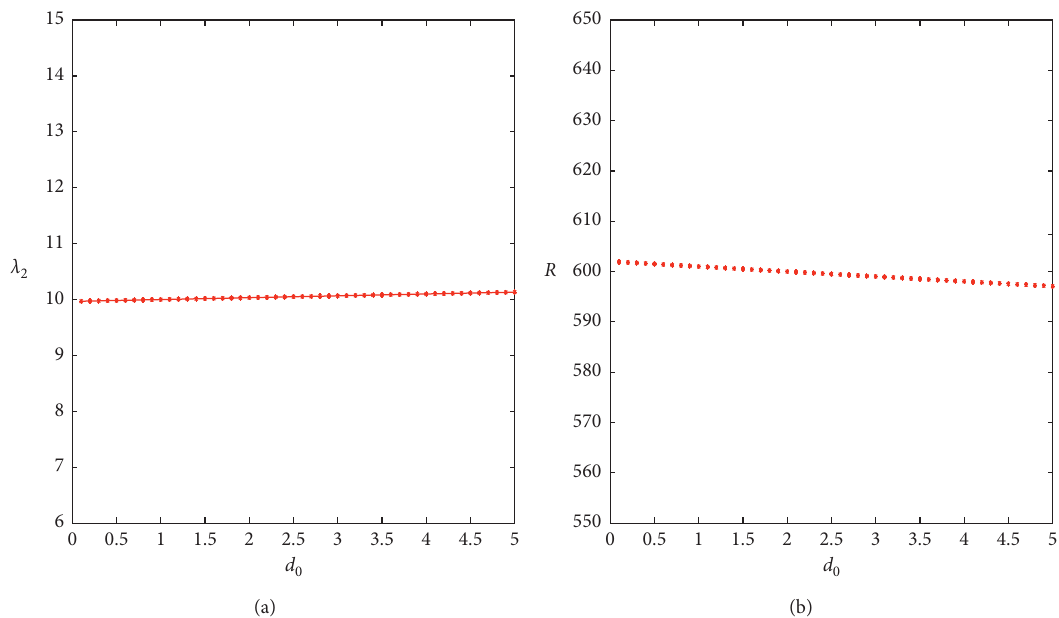
Figure 14: The synchronizability of multilayer star-ring networks vs . varying the interlayer coupling strength d 1, and a > Md ) (a) λ 2 with respect to varying d 0 . (b) R with respect to varying d 0 .